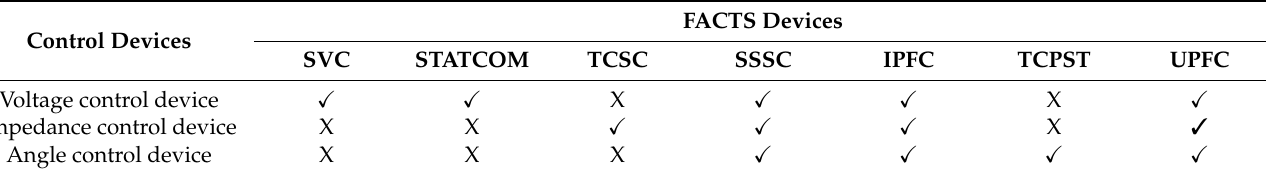
Table 1. Control mechanism of FACTs devices.